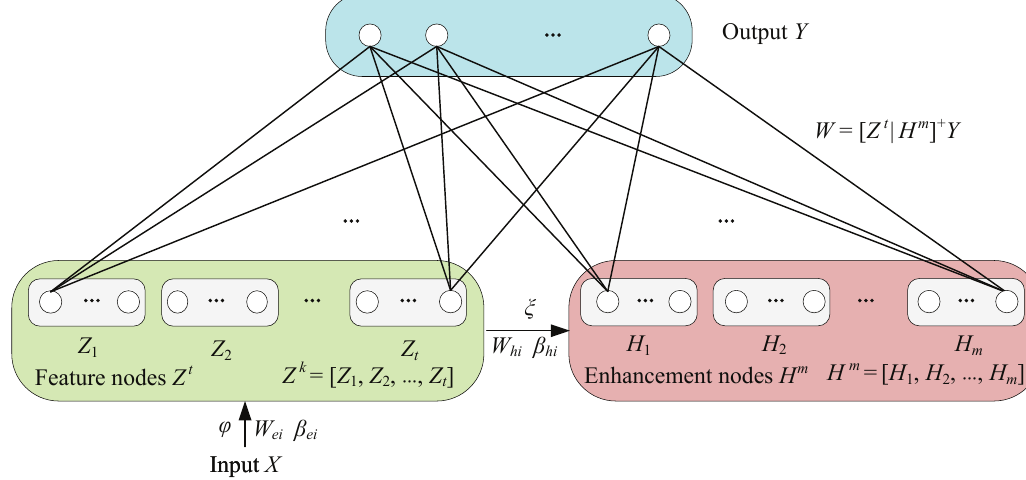
Fig. 3 The overall structure of